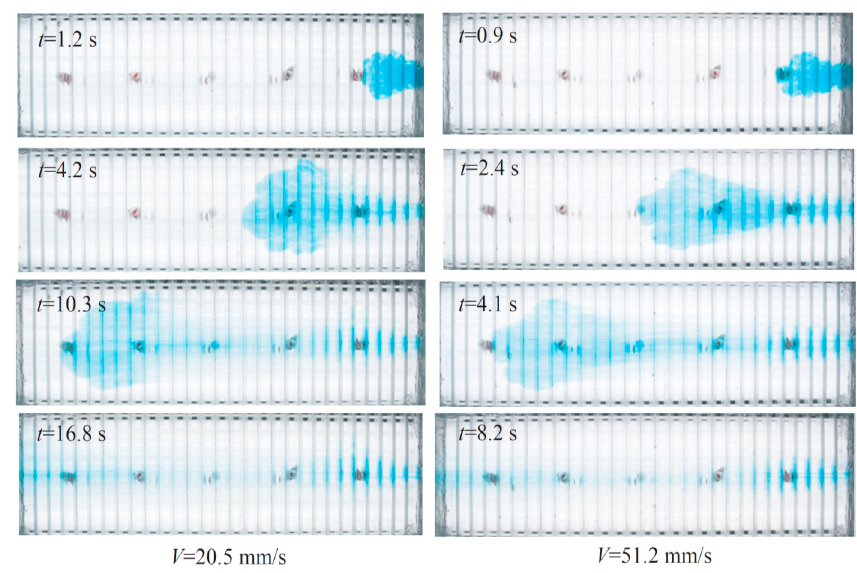
Figure 5. Solute plume of the tracer test in rough single fractures with trapezoidal roughness.